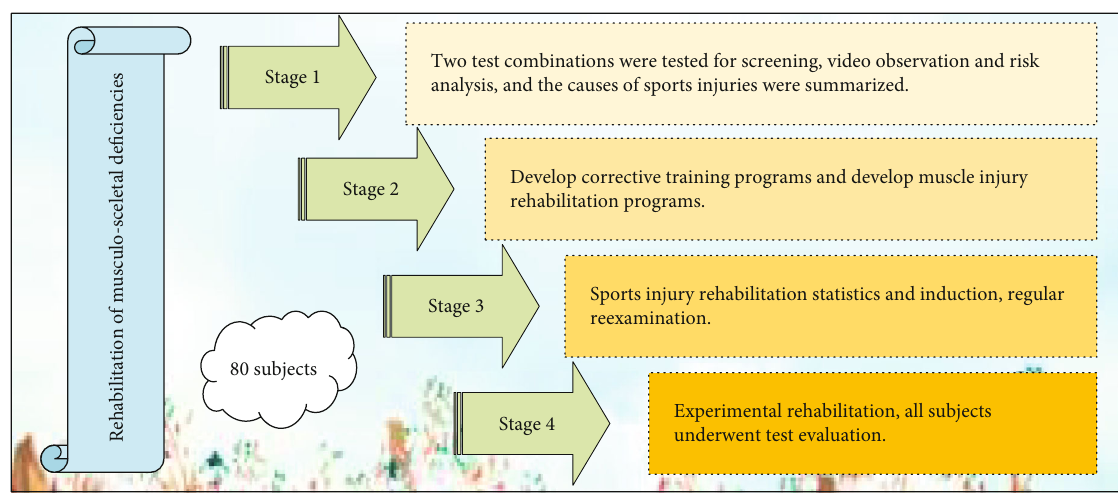
Figure 2: Flow chart of muscle injury rehabilitation test.